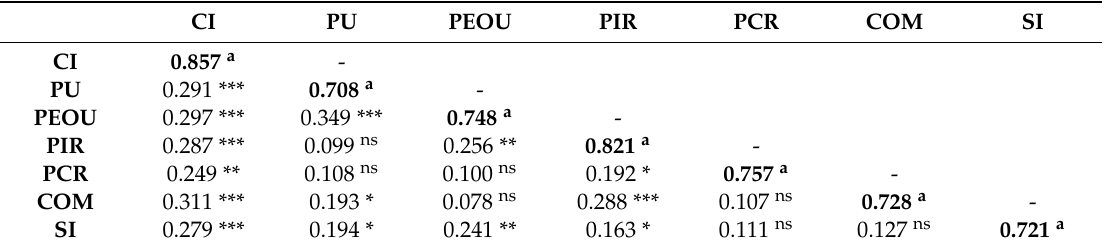
Table 3. Descriptive statistics, correlation matrix and square root of the average variance extracted (Source: Authors’